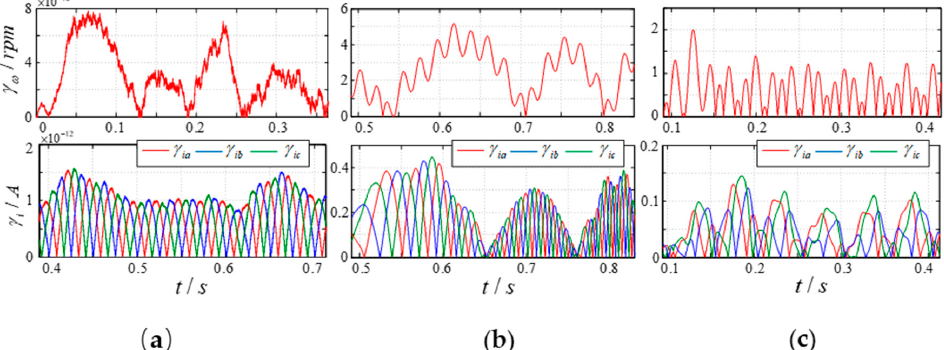
Table 1. The specific simulation